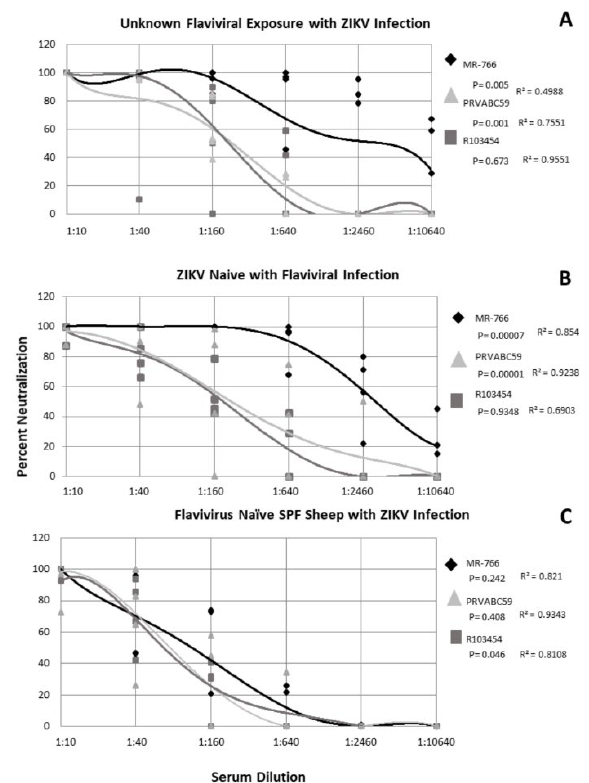
Figure 3. Neutralization of Zika viruses by subject serum with and without ZIKV exposure. Non-linear regression was performed to identify significance. Each shape represents the average inhibition of 2 replicates.